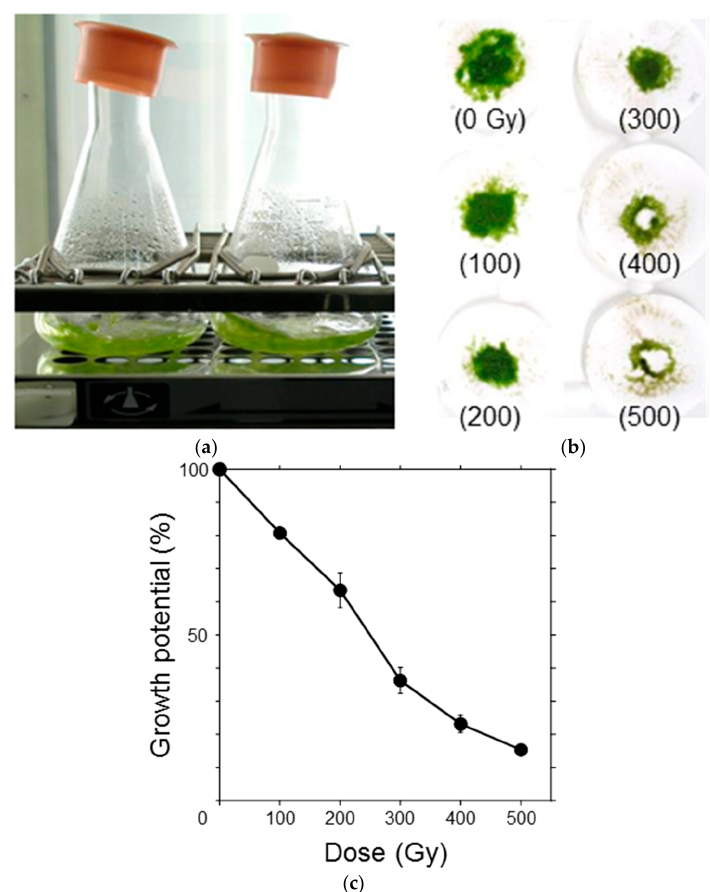
Figure 2. Growth inhibition of P. patens protonemata after γ -ray irradiation. ( a ) After irradiation, the protonemata were suspension-cultured for one week under light; ( b ) After incubation, the protonemata were filtered on paper disks, air-dried overnight, and the dry weight was measured. The absorbed doses (in gray; Gy) are specified in parentheses; ( c ) Increase in dry weight over one week was normalized, and the growth potential was plotted as a function of γ -ray dose. The data are the mean ± standard error of the mean (SEM) derived from at least three independent experiments. The growth potential decreased in a dose-dependent manner. The dose that decreased the potential by half was ~250